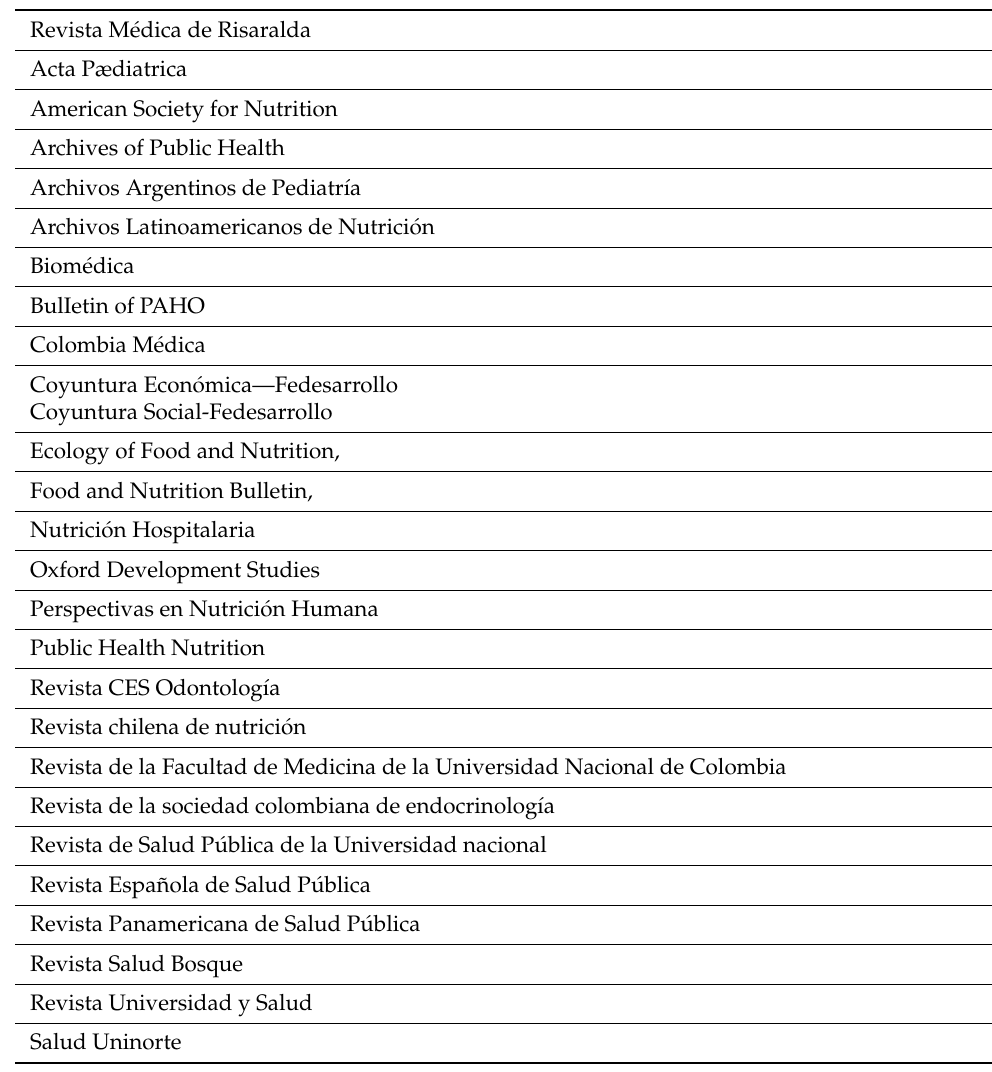
Table A3. Journals of the reviewed